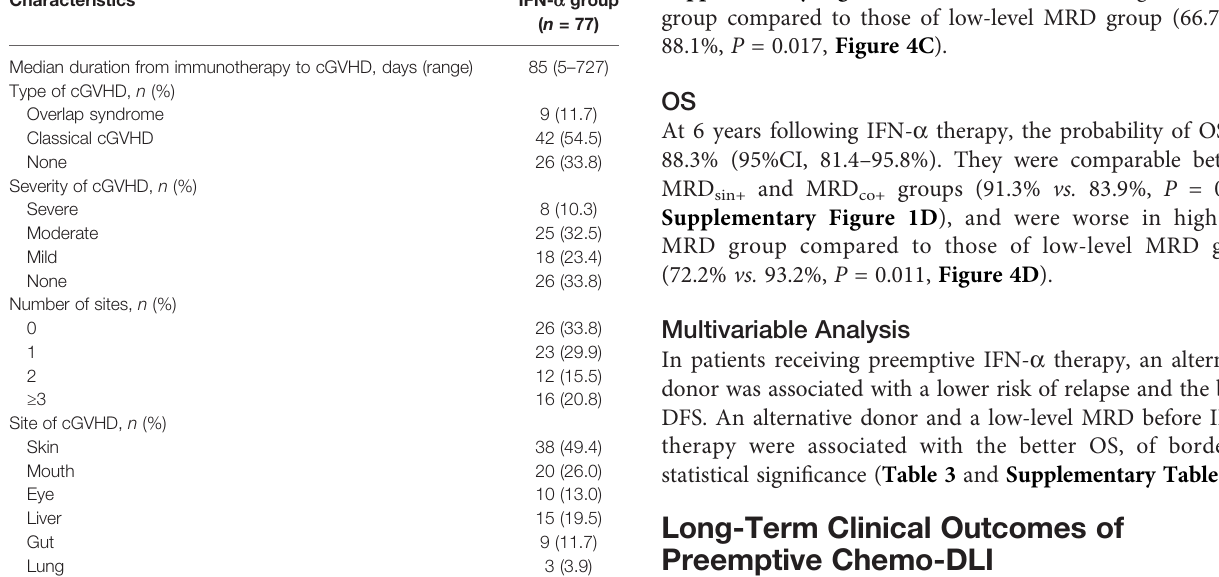
TABLE 2 | Characteristics of cGVHD after preemptive IFN- a therapy. Characteristics